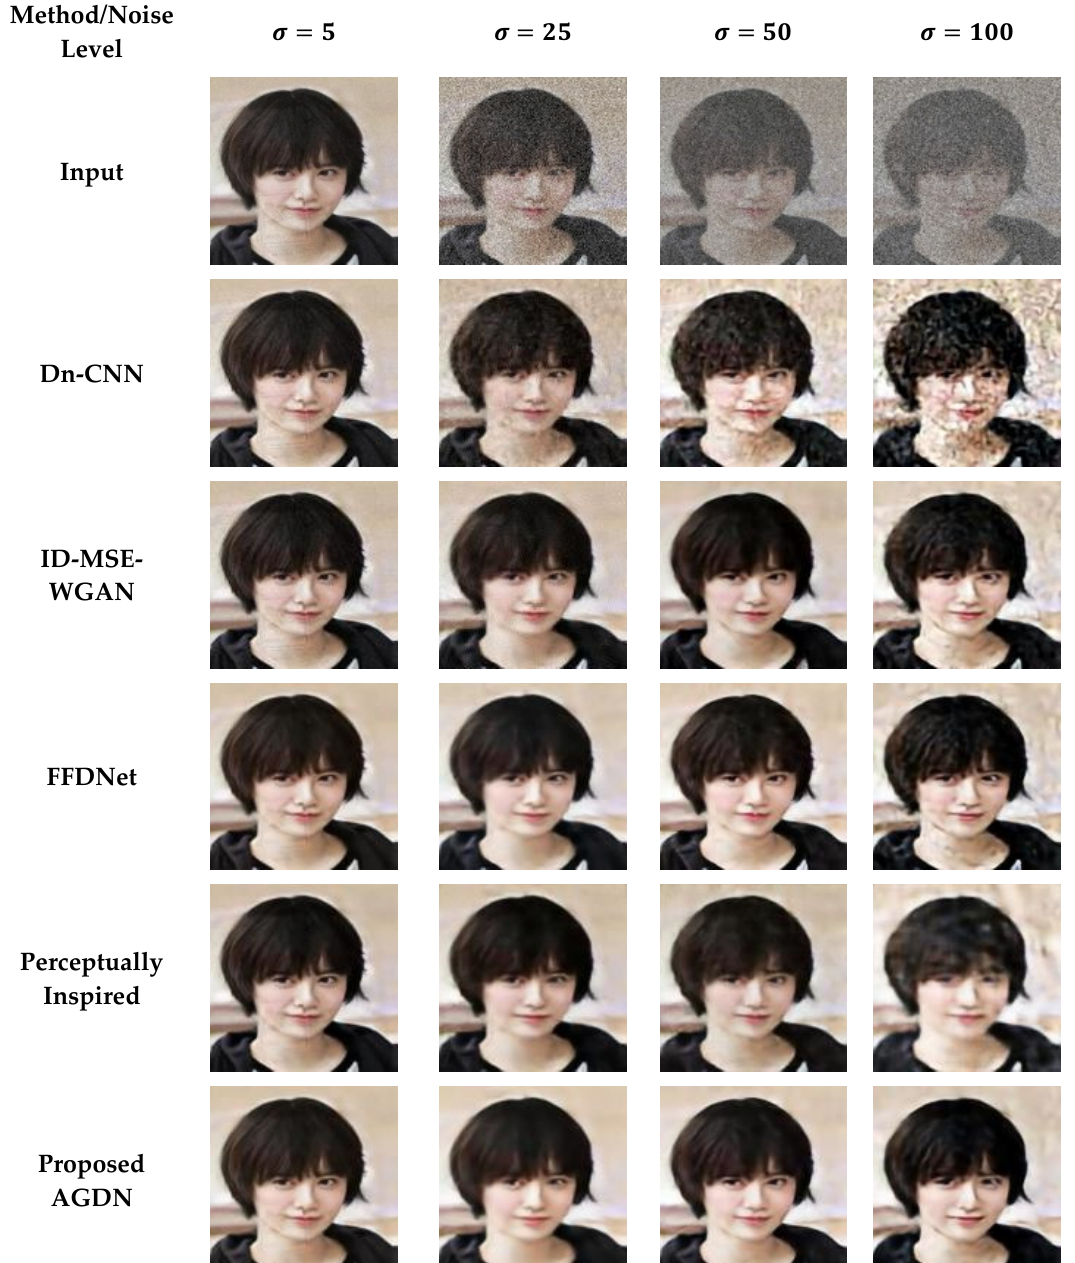
Figure 8. Second sample results of image denoising tasks on the Partial-CelebA dataset. The first to last column images were generated by the noise level of sigma 5, 25, 50, and 100, respectively. First-row shows the input images, second-row to the last-row presents the results of the Dn-CNN, ID-MSE-WGAN, FFDNet, the perceptually inspired method, and the proposed AGDN, respectively.